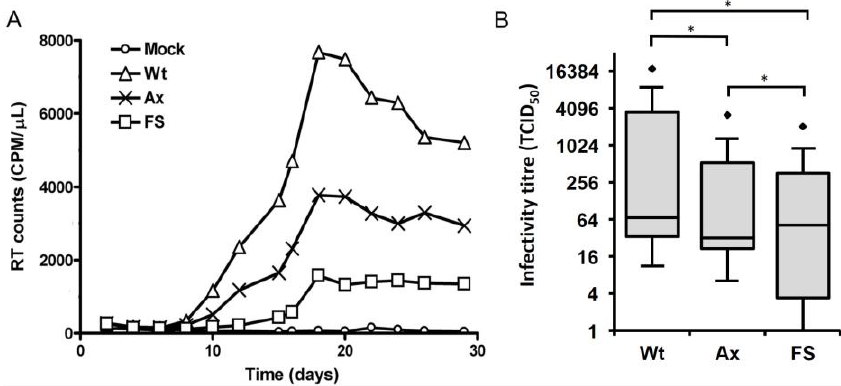
Figure 2. The effect of Nef and Nef PxxP on HIV-1 replication kinetics and infectivity in primary MDM. ( A ) HIV-1 replication kinetics in primary MDM. Cells were infected with equivalent amounts of AD8 (Wt; triangles), AD8AxxA (Ax; crosses) or AD8FSNef (FS; squares) based on cell-free RT activity. The results presented are from a single donor and are representative of experiments conducted in cells from 8 separate donors; ( B ) HIV-1 infectivity in primary MDM. Cells were infected with equivalent amounts of AD8 (Wt), AD8AxxA (Ax) or AD8FSNef (FS) based on cell-free RT activity. The infectivity titre of each virus was measured by TCID assay in primary MDMs from each of seven 50